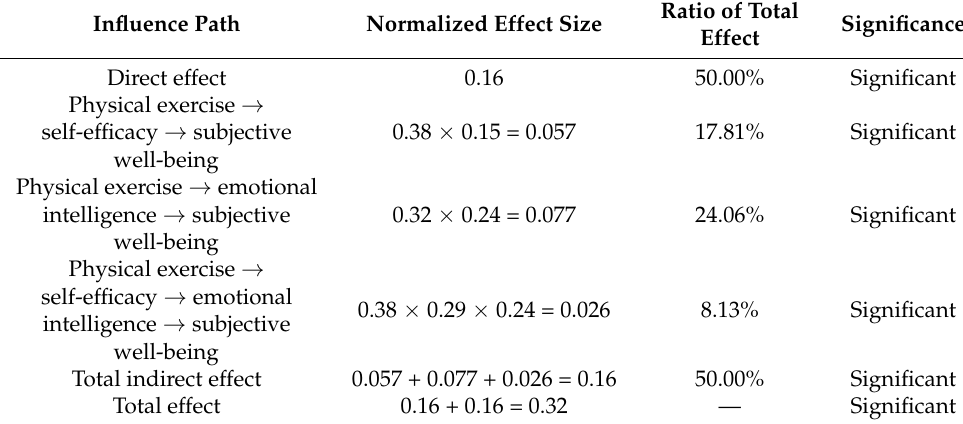
Table 3. Decomposition of the effect of physical exercise on subjective well-being.